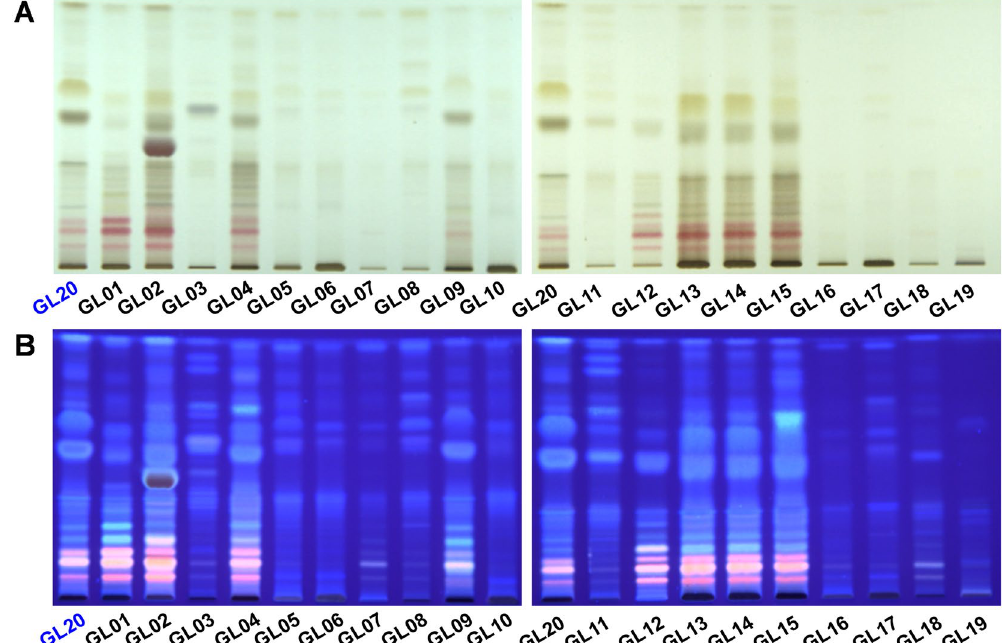
Figure 1. HPTLC fingerprints of triterpenes in G . lucidum dietary supplements. ( A ) Photographed under white light; ( B ) photographed under UV 365 nm; Sample codes were the same as in Table 1.